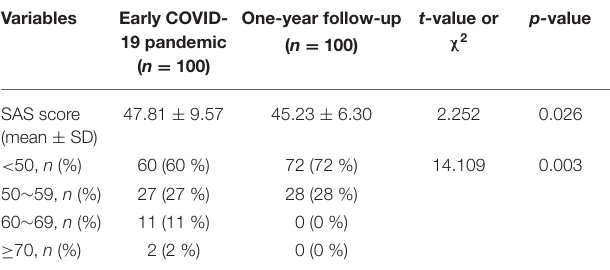
TABLE 1 | Anxiety status of hemodialysis patients in different periods of the pandemic.